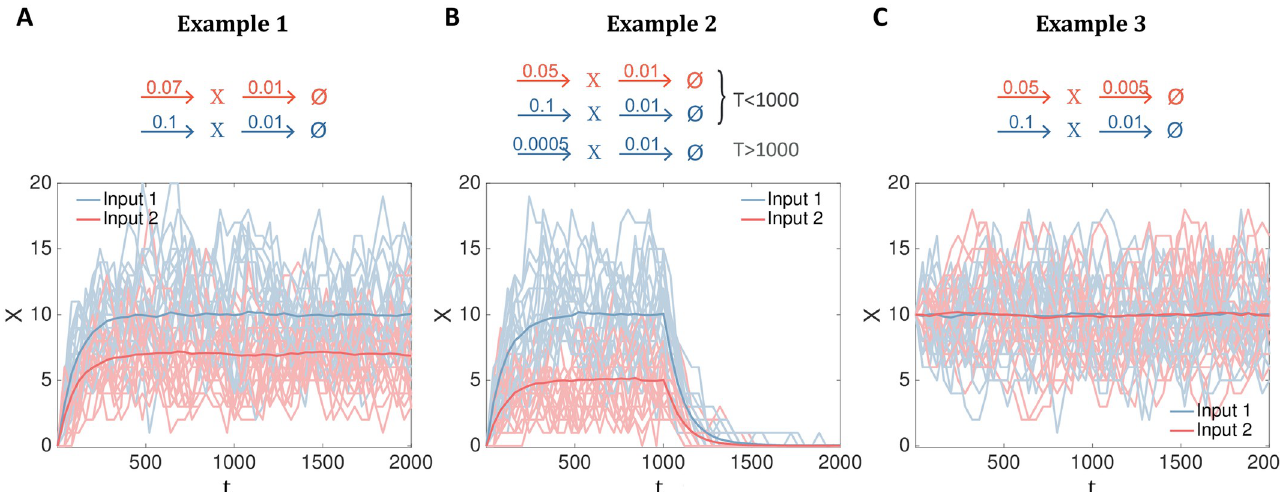
Fig 2. Example biochemical reaction networks and their behavior. Three example birth-death processes, specified by the reactions in the top row for each of the two possible inputs ( u (1) in blue, u (2) in red), stylize simple behaviors of biochemical signaling networks. (A) Input is encoded in both the transient approach to steady state and the steady state value. (B) Input is encoded in the magnitude of the transient response which is subsequently adapted away. (C) Input is encoded only at the level of temporal correlations of the response trajectory. Bottom row shows example trajectories generated using the Stochastic Simulation Algorithm for the copy number of ~ X molecules, t 2 [0, 2000], for each network and the two possible inputs (light blue, light red); while plotted as a connected line for clarity, each trajectory represents molecular counts and is thus a step-wise function taking on only integer or zero values. Dark blue, red lines show the conditional means over N = 1000 trajectory